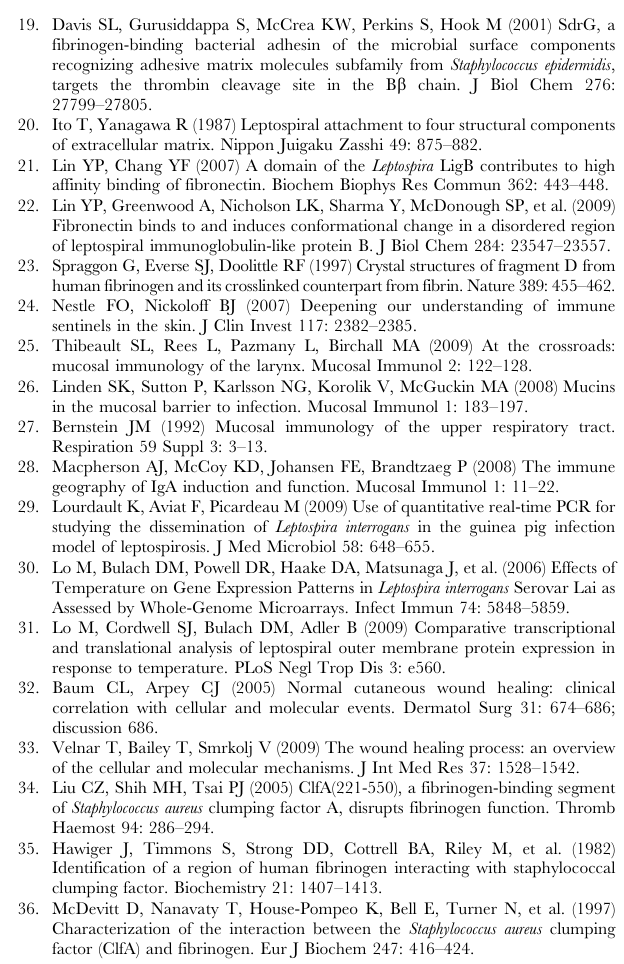
Table S1 Primers for cloning LigB